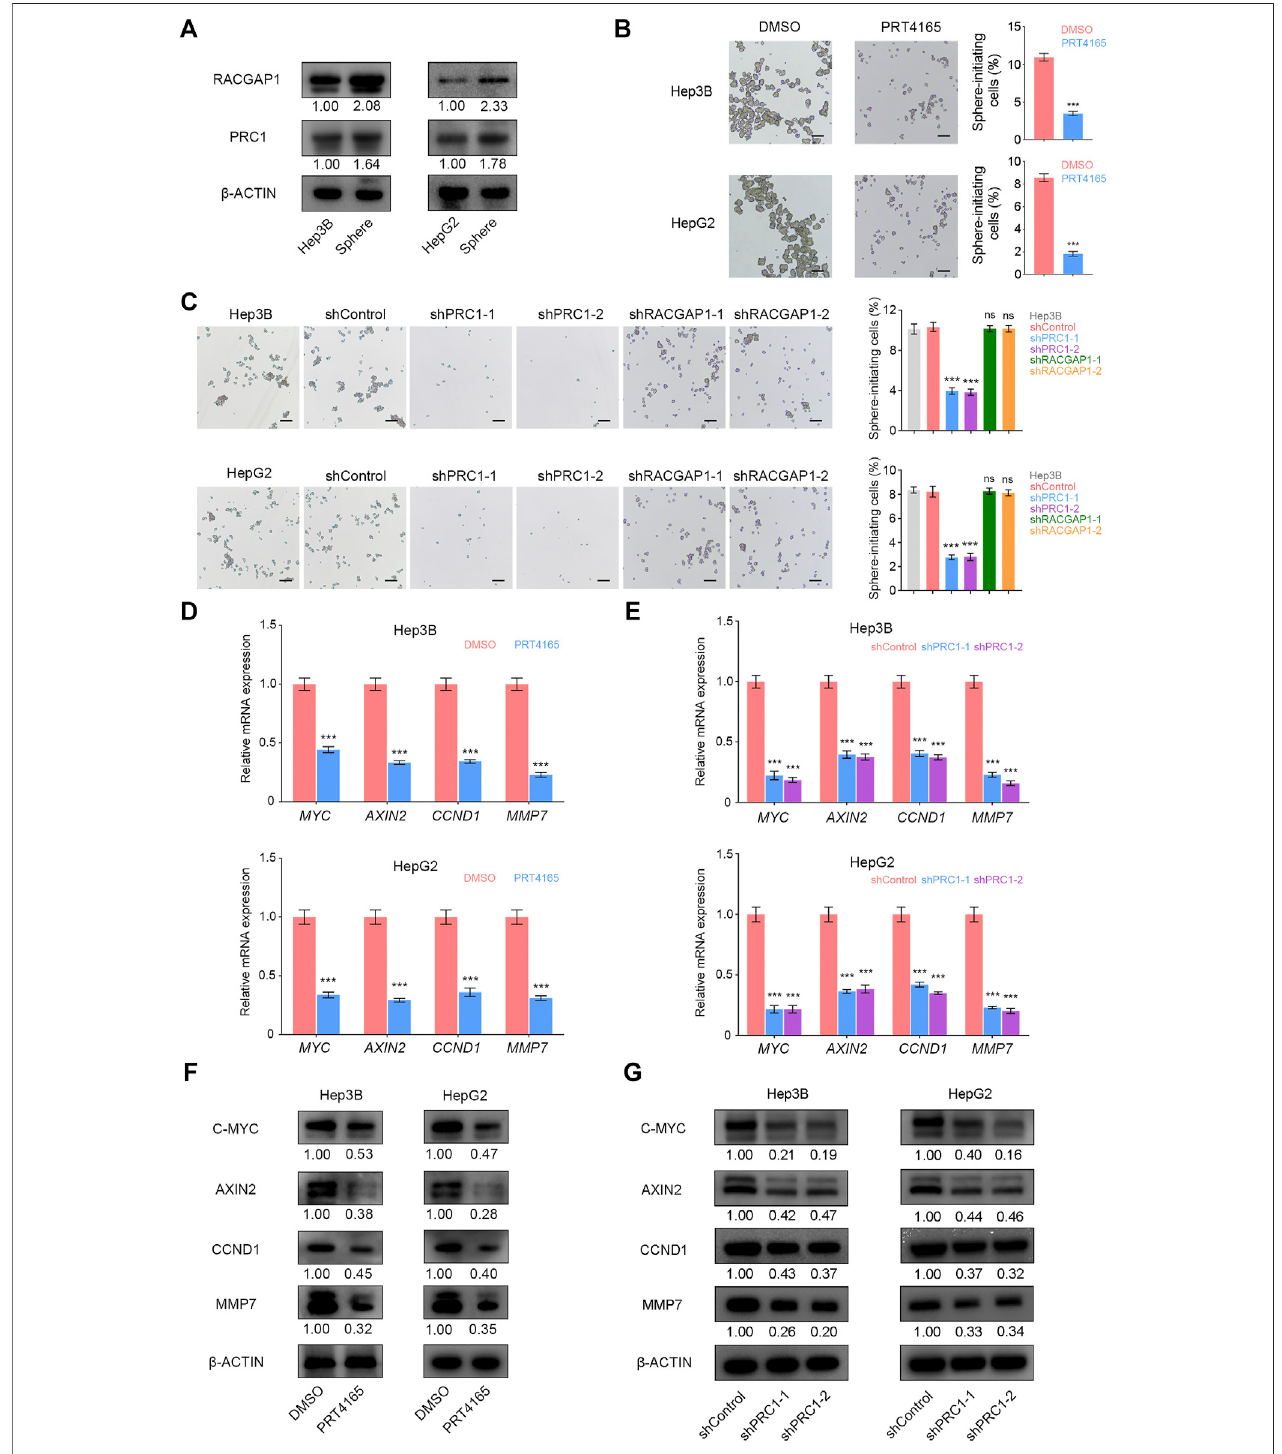
FIGURE 5 | PRC1 promotes the self-renewal of liver CSCs through Wnt signaling. (A) High expression of PRC1 and RACGAP1 in liver CSCs was detected by Western blot. (B,C) (B) 2 × 10 4 PRC1 or RAPGAP1 knockdown Hep3B (upper panels) and HepG2 (lower panels) cells; (C) 2 × 10 4 Hep3B (upper panels) and HepG2 (lower panels) cells treated with 10 μ M PRT4165 or DMSO were seeded in ultra-low attachment 6-well plates and cultured in Dulbecco ’ s Modi fi ed Eagle ’ s Medium/F12 supplemented with B27, N2, 20 ng/ml epidermal growth factor, and 20 ng/ml basic fi broblast growth factor. After three days, the sphereswere examined under a microscope. (D,E) qRT-PCR was used to verify the mRNA expression of AXIN2 , MYC , CCND1 , and MMP7 . (F,G) Protein level expression of AXIN2, C-MYC, CCND1, and MMP7 was veri fi ed by Western blot. Scale bars: 100 μ m. ns p ≥ 0.05; *** p < 0.001, data are shown as mean ± s.d. Data are representative of at least three independent